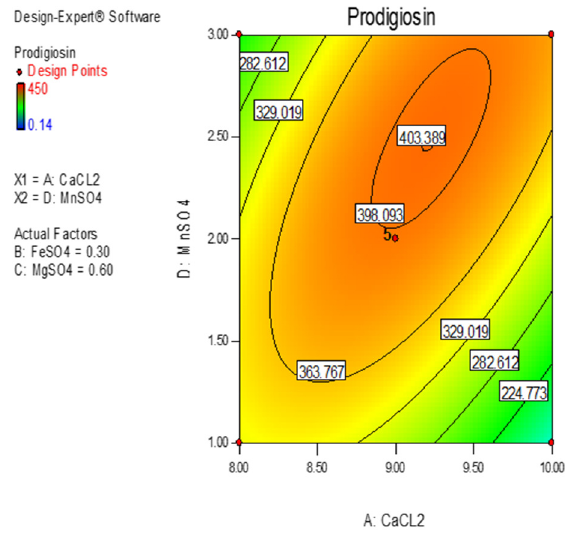
Fig. 6. effect of interaction factors CaCl 2 and MnSO 4 in medium composition for prodigiosin